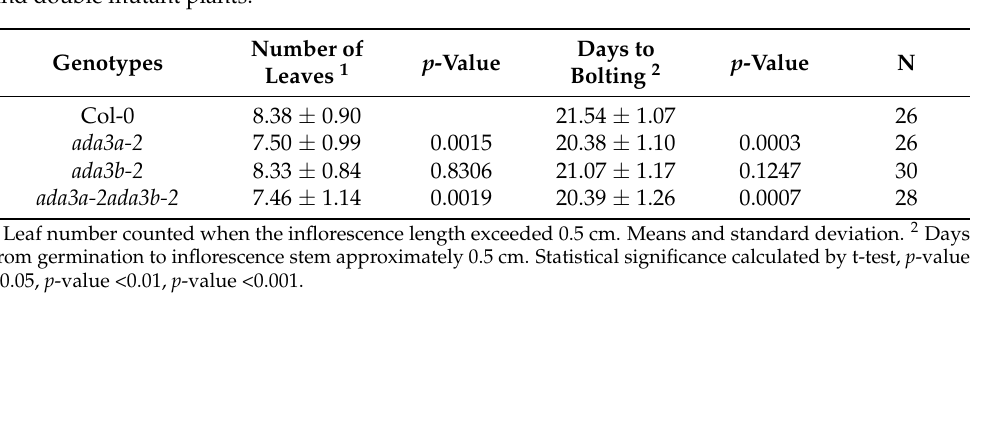
Table 1. ADA3a is involved in flowering. Leaf number and days to bolting in ada3a and ada3b single and double mutant